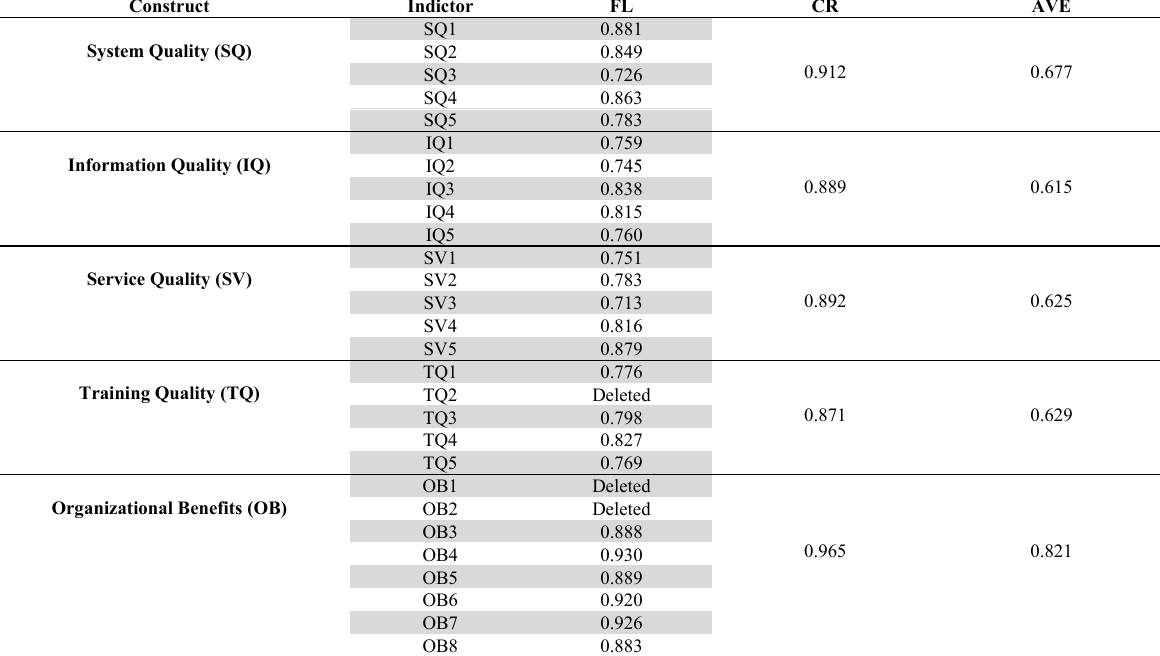
Results of convergent validity .